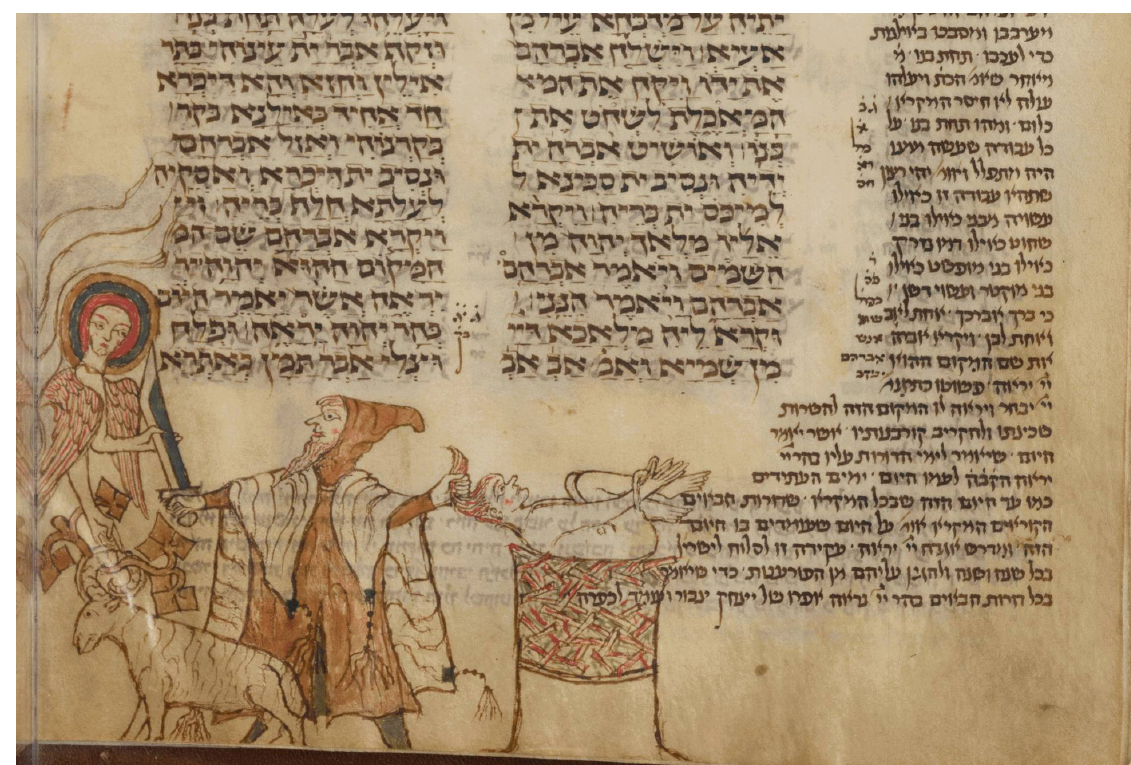
Figure 1 Brussels Pentateuch, Brussels, 1309 (Hamburg, Staats- und Universitätsbibliothek, Codex Levy 19, f.